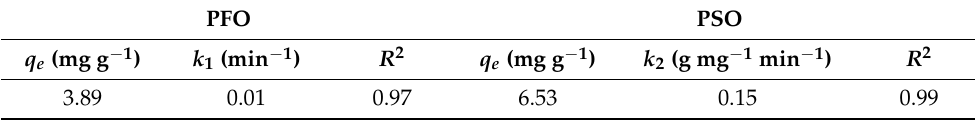
Table 1. Kinetic model parameter data for egg shell biochar.